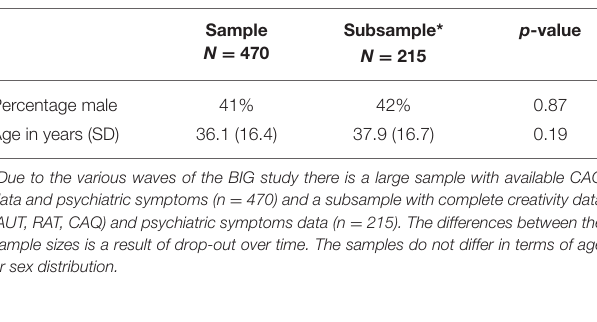
TABLE 2 | Overview of the creativity measurements and self-reported symptoms of neurodevelopmental conditions in the population-based sample (BIG study). Creativity scores